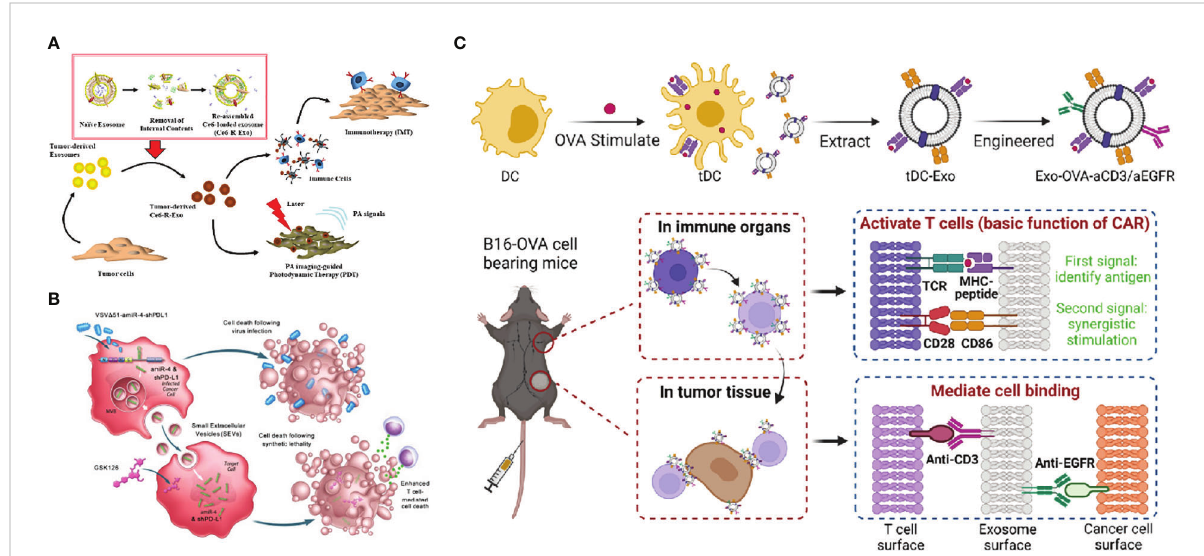
FIGURE 8 (A) Schematic diagram of photoacoustic imaging-guided combined photodynamic and immunotherapy for Ce6-R-Exo treatment (Reprinted with the permission from Ref. 191) (B) Schematic illustration of VSV D 51-amiR-4-shPD-L1 exerting enhanced T cell-mediated cancer cell death (Reprinted with the permission from Ref. 192) (C) The above diagram is a schematic view of the construction of the engineered tDC-Exo (Exo-OVA-aCD3/aEGFR) with anti-CD3 and anti-EGFR antibodies. The bottom diagram shows the simulated CAR-T treatment process (Reprinted with the permission from Ref. 193). R-Exo; re-assembled exosome, Ce6-R-Exo; chlorin e6-loaded R-Exo, IMT; immunotherapy, PDT; photodynamic therapy, PA; photoacoustic, VSV D 51-amiR-4-shPD-L1; VSV D 51 oncolytic viruses- arti fi cial microRNA-4- shPD-L1, MVB; multivesicular bodies, SEVs; small extracellular vesicles, DC; dendritic cells, tDC-Exo;tumor antigen-stimulated dendritic cell-derived exosomes, aEGFR; anti-epidermal growth factor receptors antibodies, OVA; ovalbumin, CAR; chimeric antigen receptor, TCR; T cell receptor, MHC; major histocompatibility